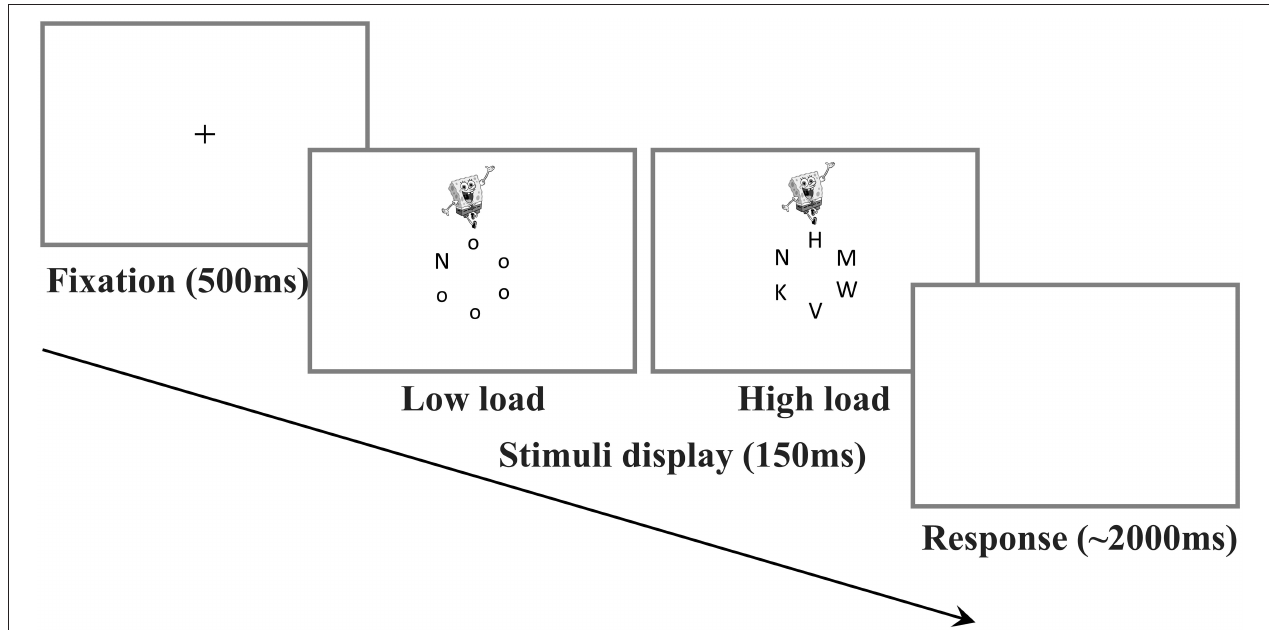
FIGURE 1 | Trial example of the irrelevant distractor task. Note. The figures show the load condition (low vs. high) and the distractor condition (distractor vs. no-distractor) of the irrelevant distractor task. Both stimuli display of low and high load conditions include only distractor condition (Spongebob).